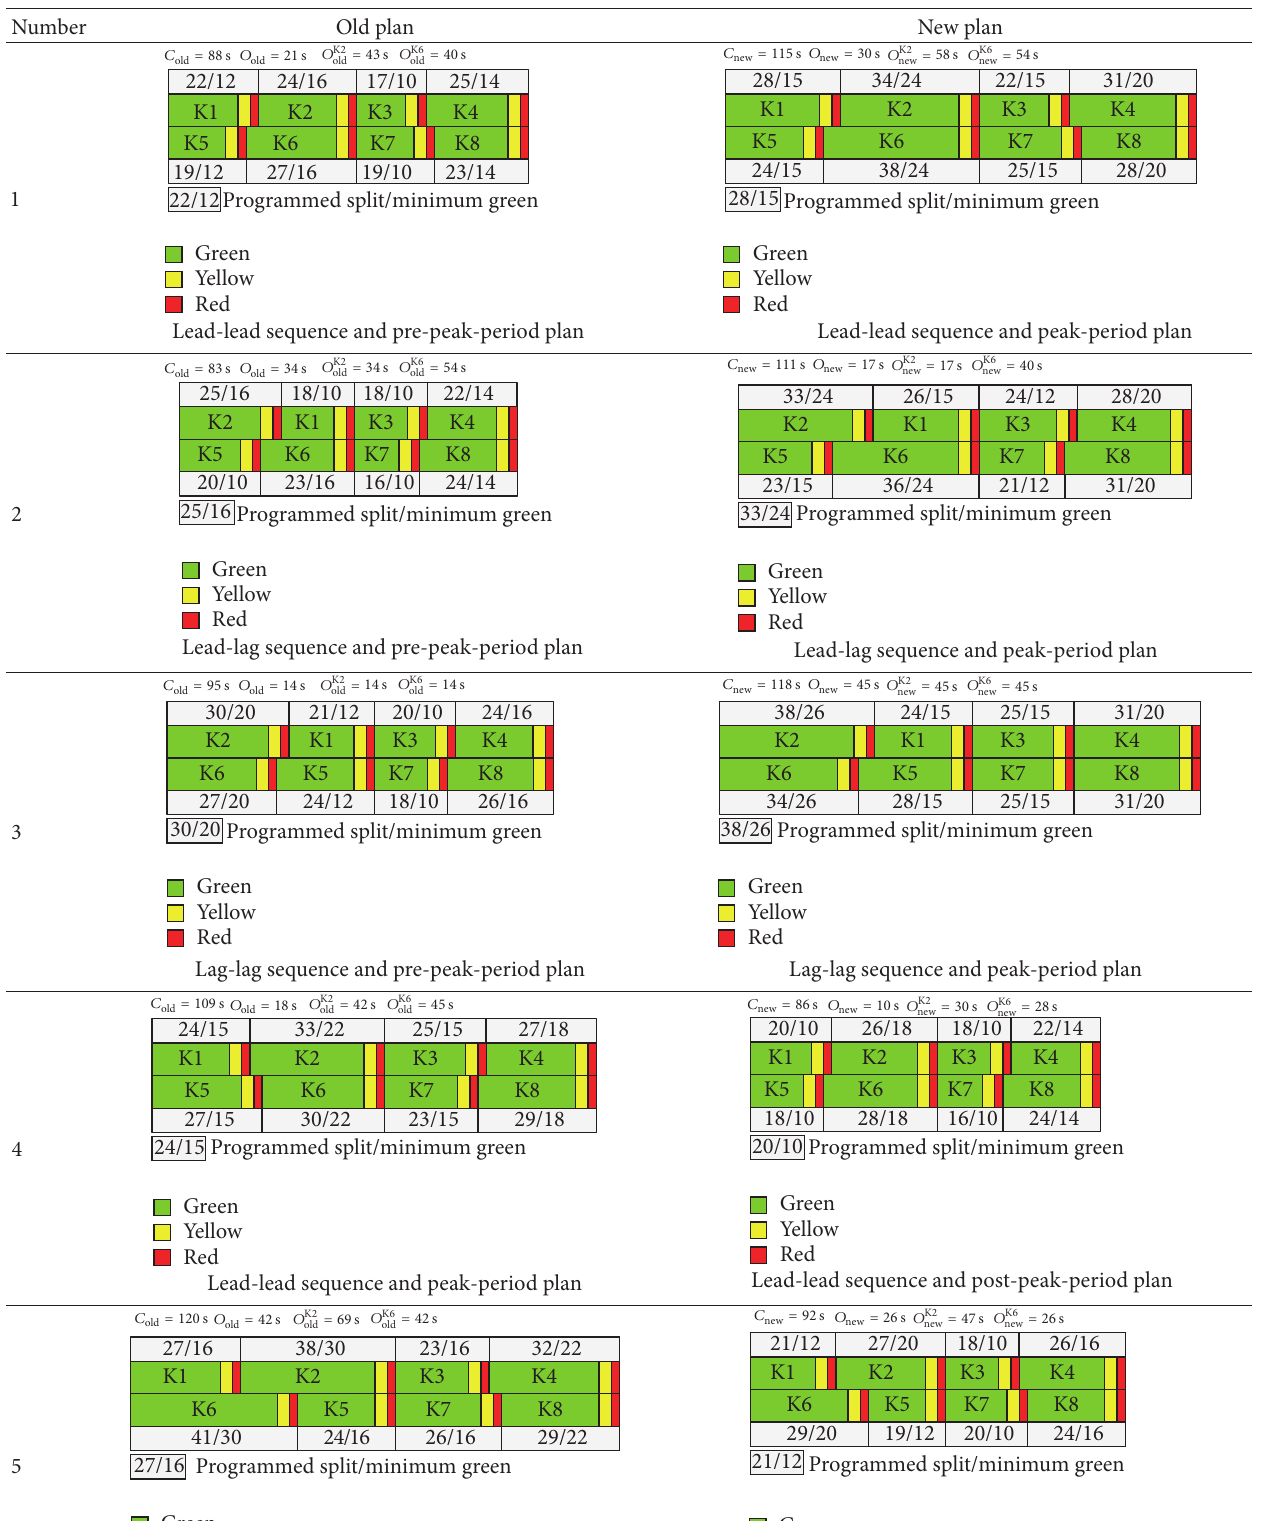
Table 2: Old and new plans for experiments 1 to